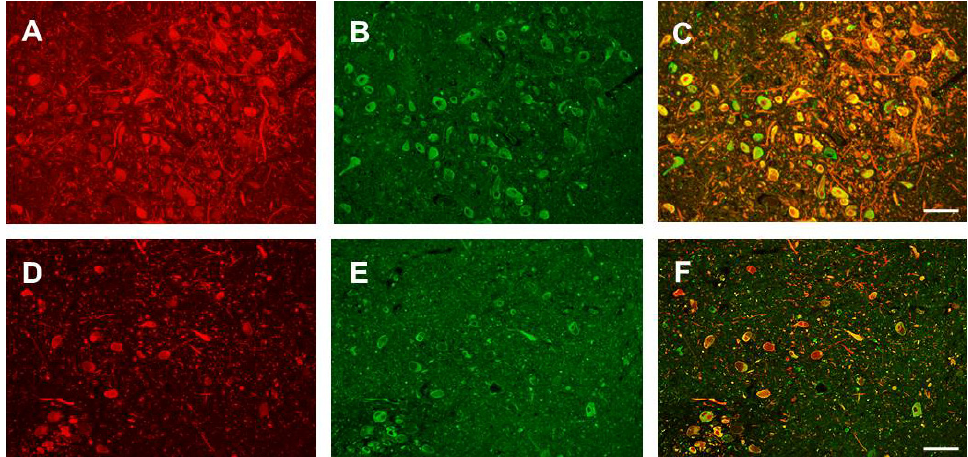
Figure 2. Digitalized photomicrographs of a 72-year-old PD male (upper row) and a 90-year-old PD male (lower row) specimen stained for tyrosine hydroxylase ( A , D ) and Nogo-A ( B , E ). Note the overall higher densities of neurons and a higher co-localization rate in the 72-year-old as compared to the 90-year-old specimen ( C , F ). Scale bars: 100µm.